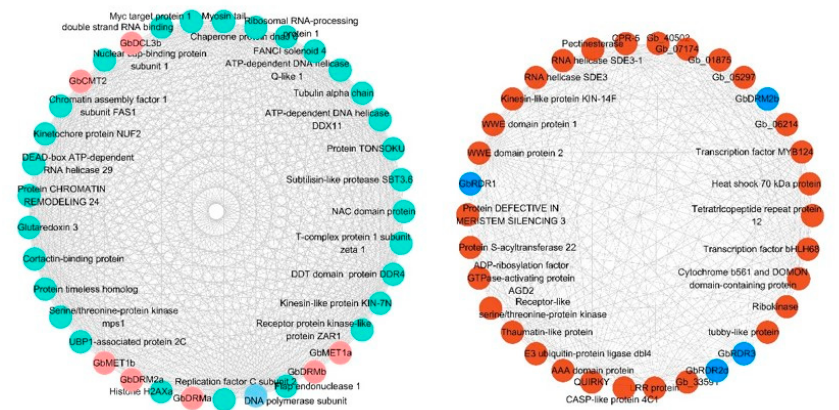
Figure 8. Top 30 genes coexpressed with group I (pink) and group II (blue) DNA methylation pathway genes, respectively. Turquoise and brown show the modules that the coexpressed genes belong to. The cut-off Pearson Correlation Coefficient (PCC) of 0.85 was used.